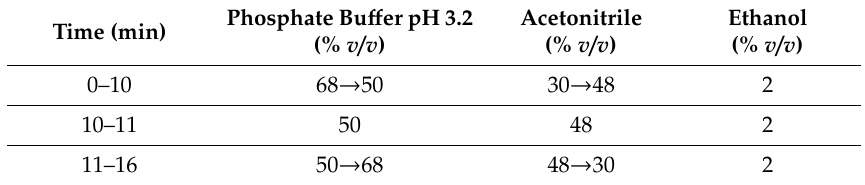
Table 2. The gradient of the mobile